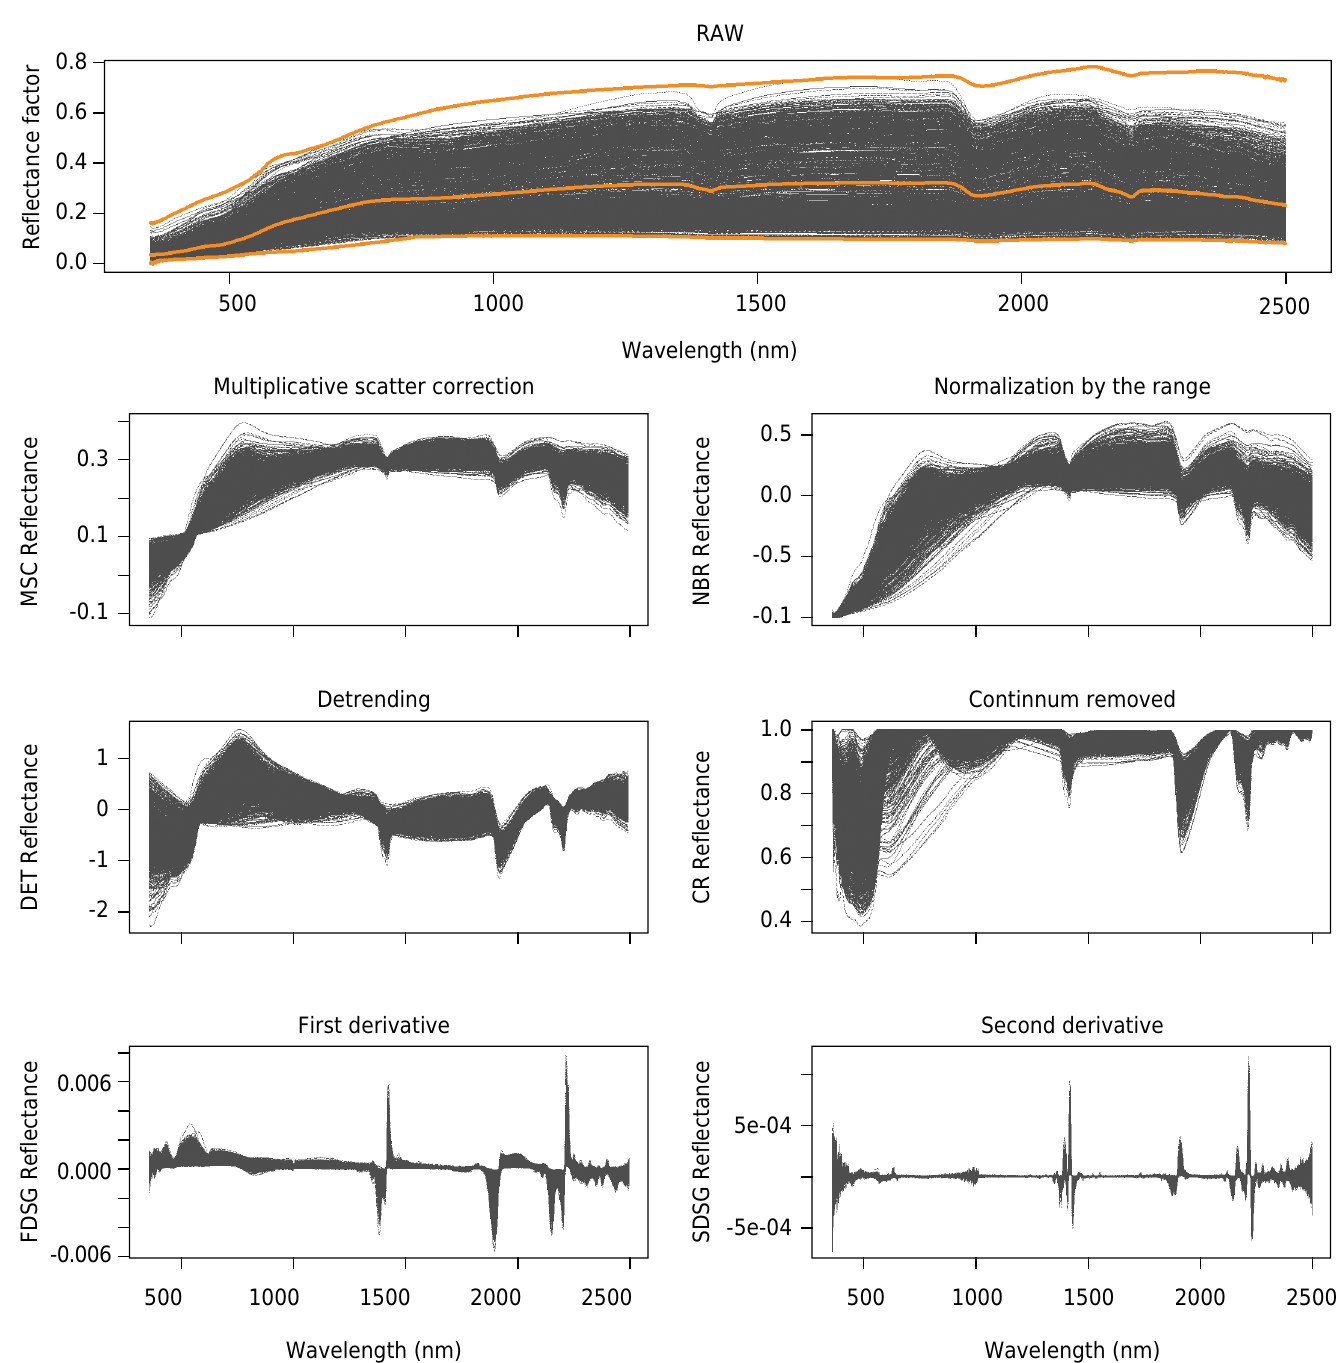
Figure 2. VIS-NIR-SWIR reflectance spectra and the preprocessing techniques of the spectral curves for all soil samples. The highlighted raw spectra correspond to the mean, the lowest, and the highest reflectance spectra of the soil